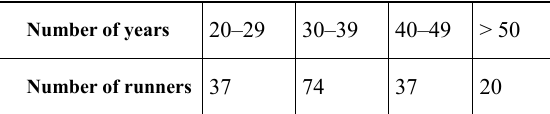
Table 2. Number of years of participation in run